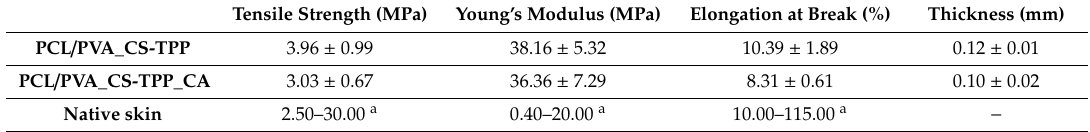
Evaluation of the mechanical properties of the produced Polycaprolactone (PCL) / Poly(vinyl alcohol) (PVA) and Chitosan-Sodium tripolyphosphate (CS-TPP) (PVA_CS-TPP) nanofibrous membranes with and without crude Centella asiatica (L.) (CA) extract and comparison with the native human skin